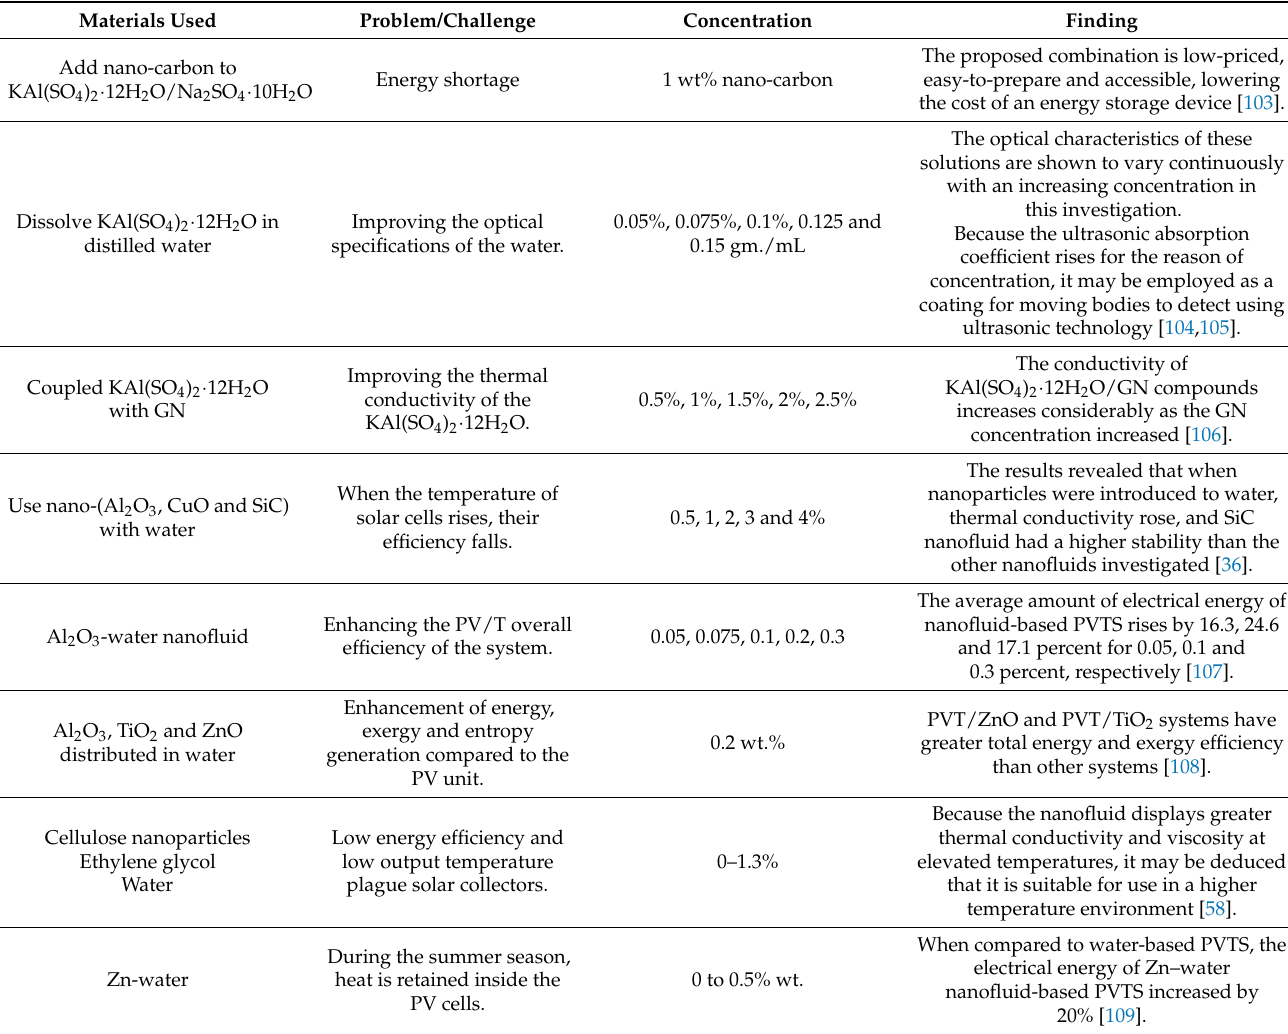
Table 4. Using nanomaterials in thermal